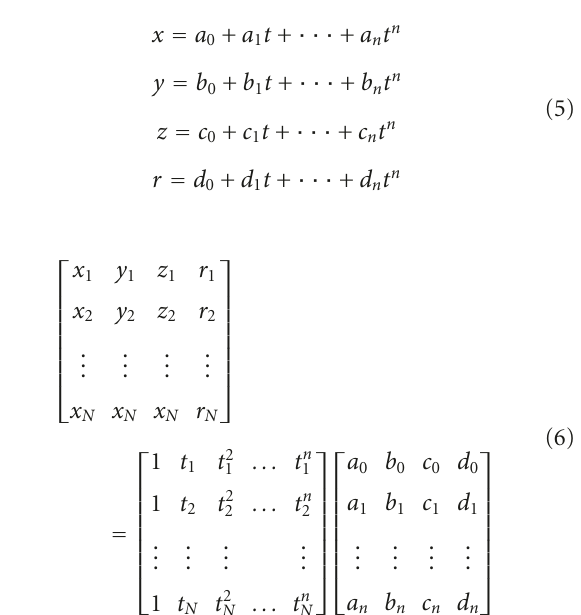
A variable t (0 ≤ t ≤ 1) was generated in such way that d ( l ) /d ( t ) (cid:2) = l , where l is the total length of the centreline polygon defining the anatomical structure. A polynomial function of t (0 ≤ t ≤ 1) was fitted to the centreline and its corresponding radii by a least-squares criterion. The output of the algorithm was a set of directed, 4-dimensional points indicating the ( x , y , z ) spatial position of each sequential vessel or nerve skeleton point with an associated radius at each point. The total generated equation consisted of x , y , z representing the centreline, and r representing the